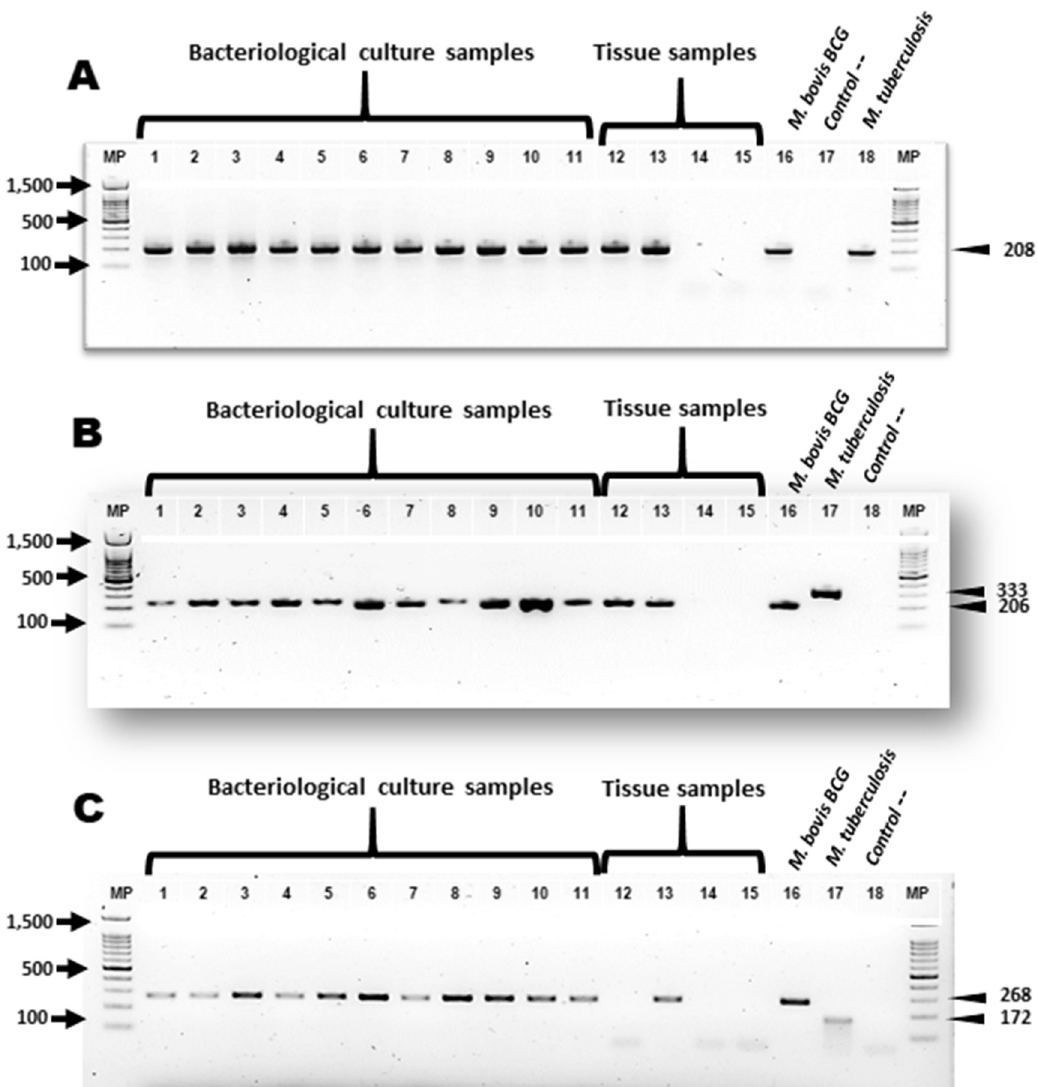
Fig 6. Molecular identification of M . bovis in naturally infected cattle. (A) Nested PCR amplification products of the 208 bp mpb70 gene. (B) Endpoint PCR of the 206 bp fragment from the M . bovis RD9 gene and the 333 bp fragment from the M . tuberculosis gene. (C) Endpoint PCR of the 268 bp fragment from the M . bovis RD4 gene and the 172 bp fragment from the M . tuberculosis gene MP molecular weight marker is 100 bp; lanes 1–11: bacteriological culture samples; lanes 12–15: negative tissue samples; and lanes 16–18: positive controls ( M . bovis BCG and M . tuberculosis H37rv) and negative